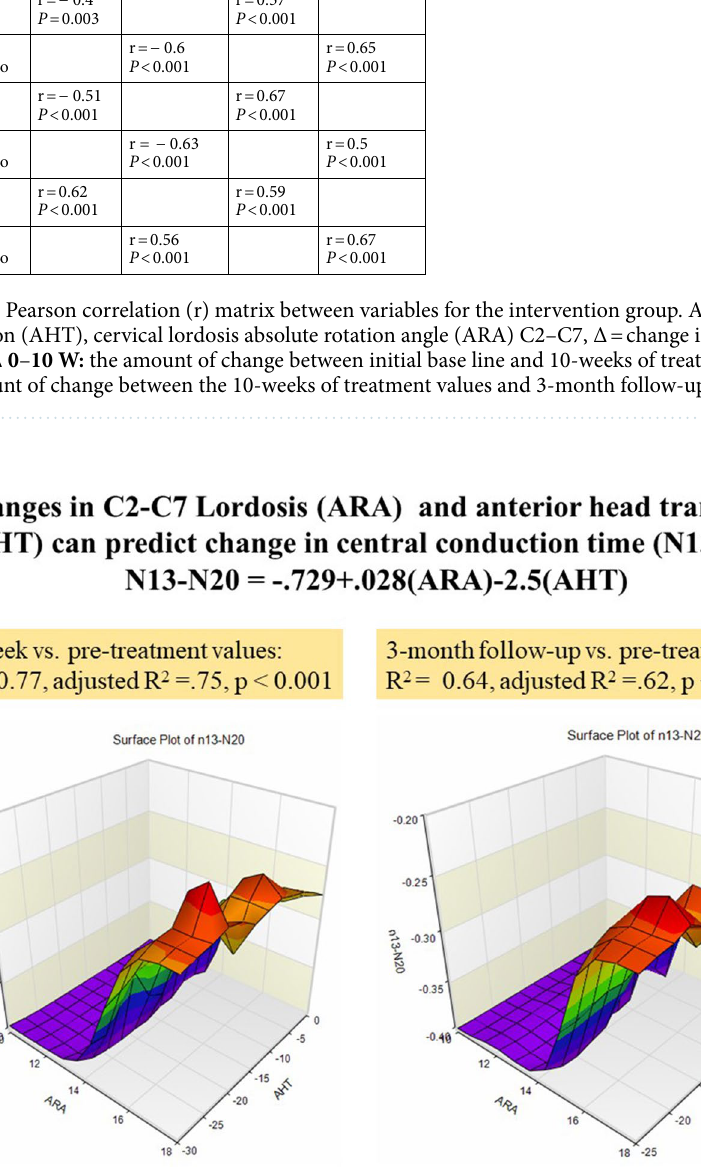
Figure 5. A statistically significant, multiple regression model to predict central conduction N13–N20 from cervical lordosis (absolute rotation angle or ARA C2–C7) and anterior head translation (AHT) was identified for the intervention group as no such relationship existed for the control/placebo group. Left: the 10-week versus pre-treatment ( P < 0.001). On the right: the 3-month follow-up versus pre-treatment ( P < 0.001). Note as AHT reduces towards 0 mm and lordosis ARA C2–C7 becomes more lordotic, N13–N20 becomes faster in